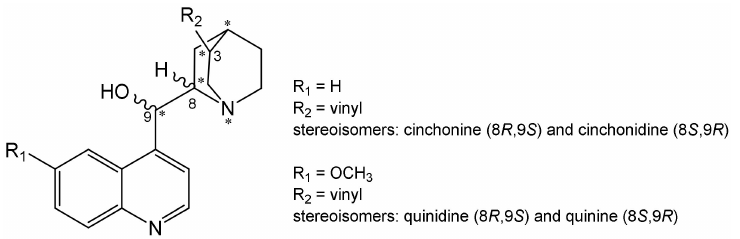
Figure 1. General structures of main Cinchona alkaloids. “*” denotes five chiral centers in the